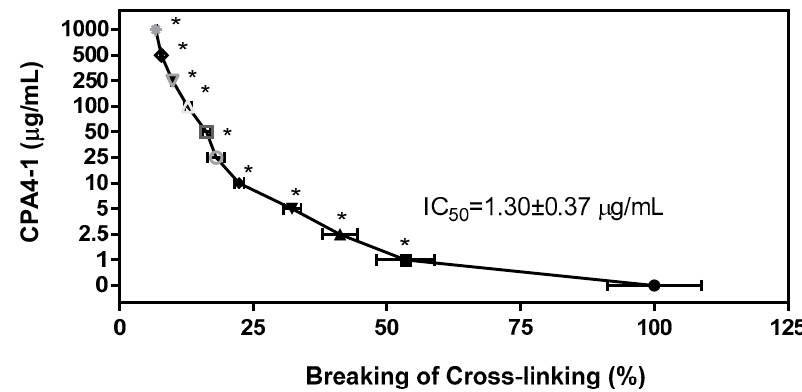
Figure 3. Breaking effect of CPA4-1 on AGE-BSA cross-linking with collagen. IC 50 (50% inhibition concentration) values were calculated from the dose-inhibition curve. Data are expressed as mean ± SD (n = 4). * p < 0.001 vs. Con (0 μ g/mL).